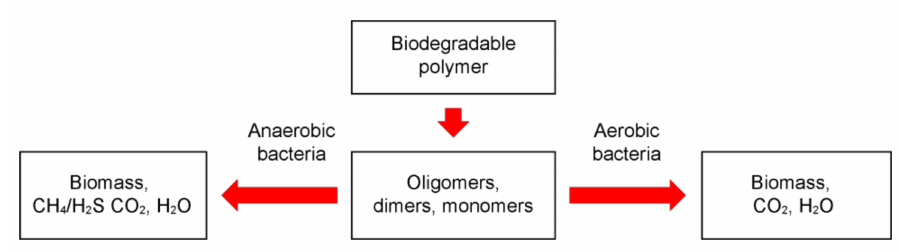
Figure 3. Biodegradation of polymeric materials under aerobic and anaerobic